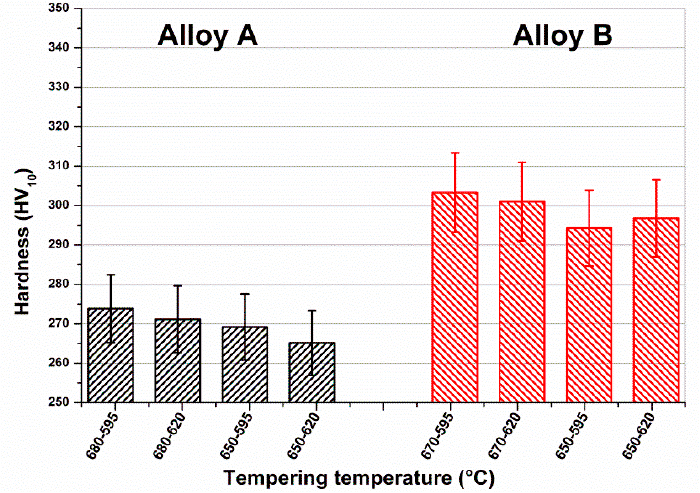
Figure 13. Hardness values for Heat A and Heat B in function of double tempering treatments.